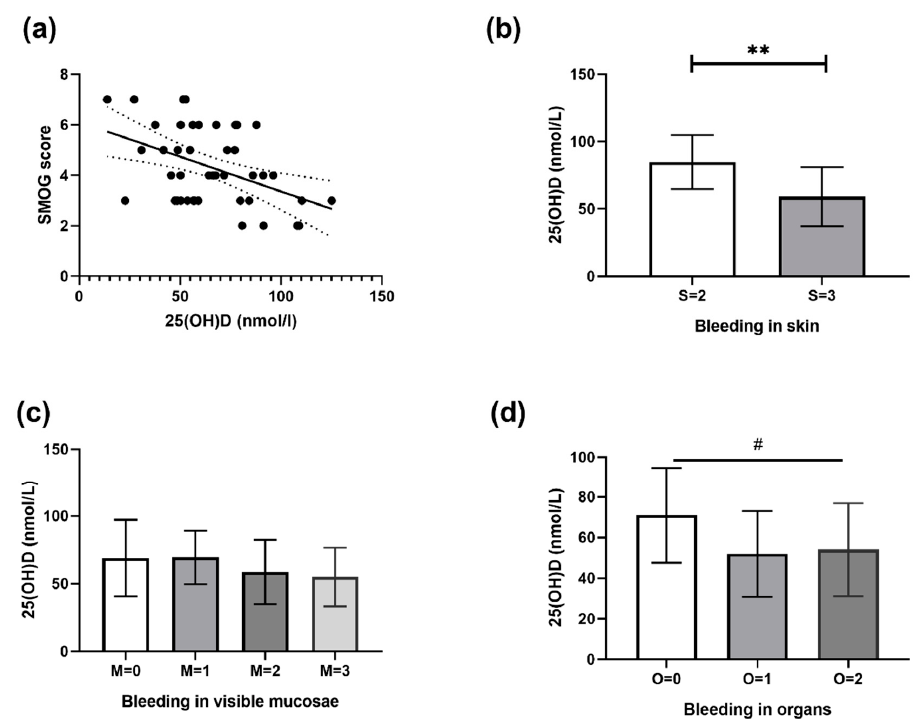
Figure 1. ( a ) Graph of linear regression between 25(OH)D value and skin-mucosa-organ-gradation (SMOG) bleeding score. The mean slope was − 0.027, with the intercept at 5.99, while the 95% confidence interval (CI) was at − 0.04 to − 0.007 (intercept 4.6 to 7.3). R 2 = 0.15, p = 0.006. ( b ) Difference between mean 25(OH)D values of two groups of patients with bleeding in skin (S) ratings 2 and 3 calculated with SMOG score ( t test, p = 0.001, 95% CI 10.5 to 40.5). ( c ) Distribution of mean 25(OH)D values in groups of patients with a different severity of bleeding in mucosae using the linear trend test. ( d ) Distribution of mean 25(OH)D values in groups of patients with a different severity of bleeding in organs (calculated with SMOG score) using the linear trend test (slope − 9.55, 95% CI − 0.54 to − 18.56, and p = 0.03). R 2 coefficient of determination, ** 0.001 ≤ p < 0.01 for t test, # 0.01 < p < 0.05 for test for linear trend. S: Skin, M: Mucous membranes, O: Organs